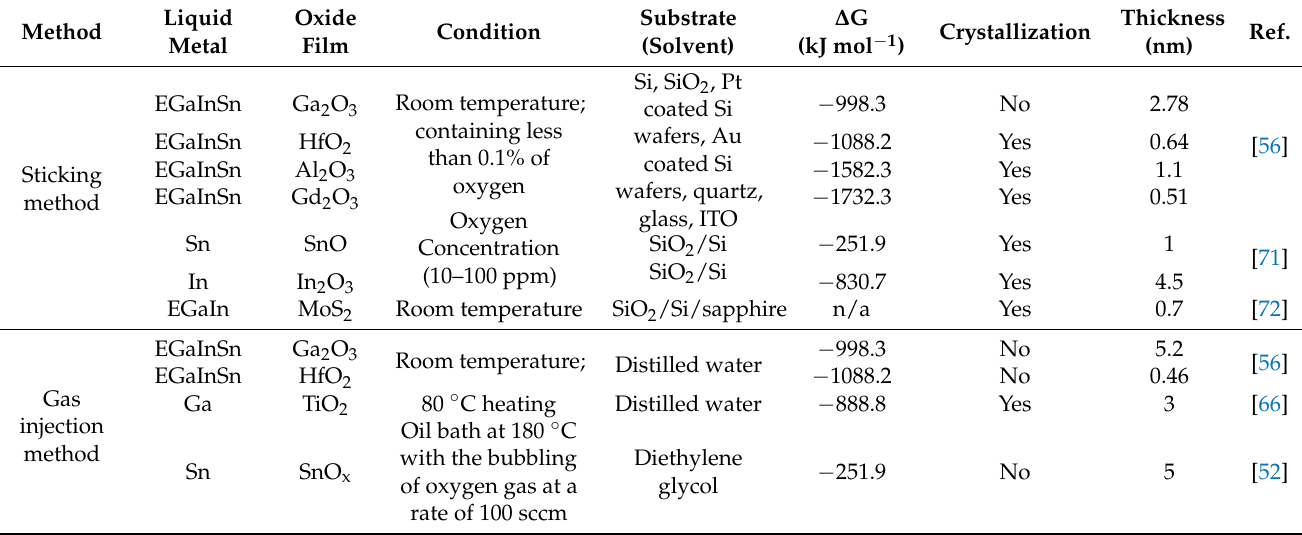
Table 1. Key factors of 2DMOs obtained from liquid